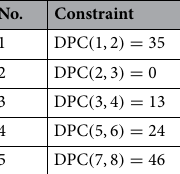
Table 2. DP constraints of the